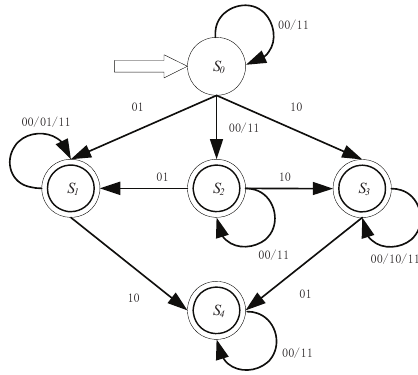
Figure 1. A Deterministic Finite Automaton for Row